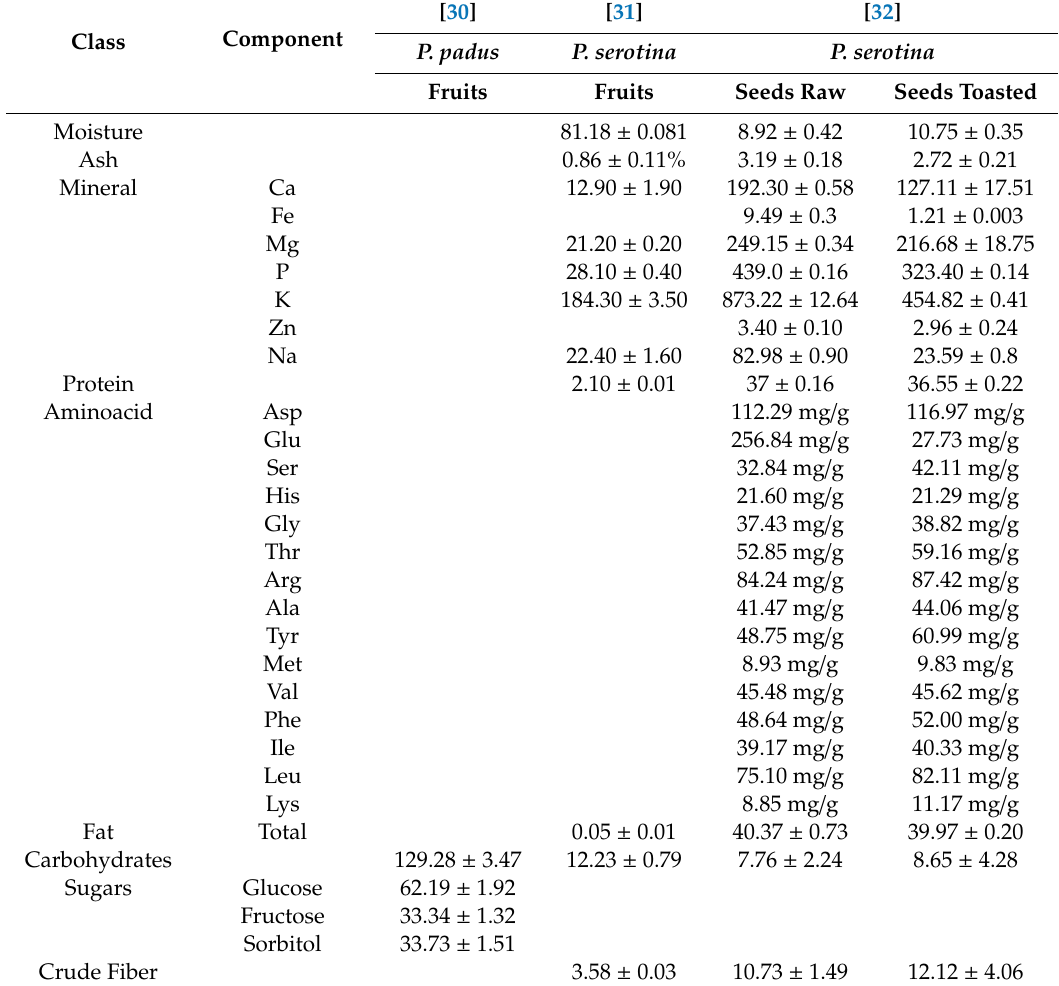
Table 3. Nutrition value and mineral content in P. padus i P.